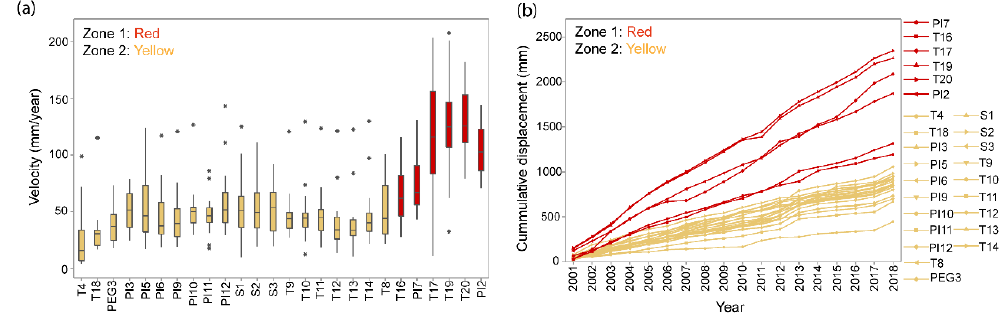
Figure 4. The horizontal displacement velocity of 26 geodetical observation points in Guarumales for 18 years, indicating Zone 1 (red, higher velocity) and Zone 2 (yellow, lower velocity. ( a ) Boxplots, ( b ) Cumulative horizontal displacement.